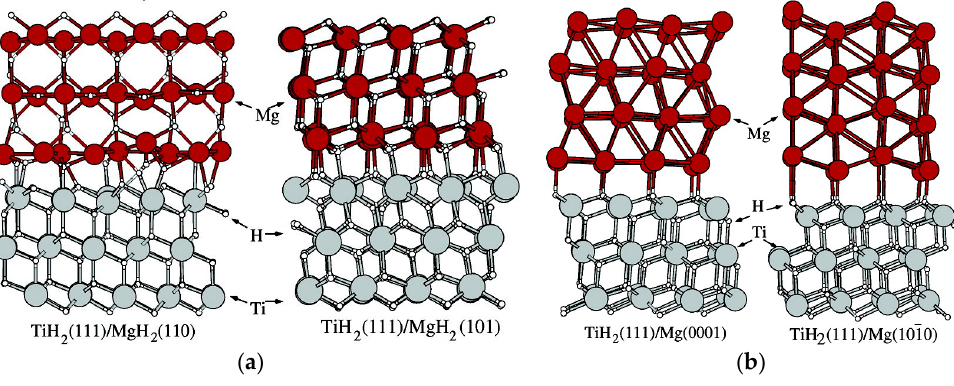
Figure 2. ( a ) Interface structure of TiH 2 (111)/MgH 2 (110) and TiH 2 (111)/MgH 2 (101); ( b ) Interface structure of TiH 2 (111)/Mg(0001) and TiH 2 (111)/Mg(10–10). Reprinted with permission from [32]. Copyright 2012 American Chemical Society.